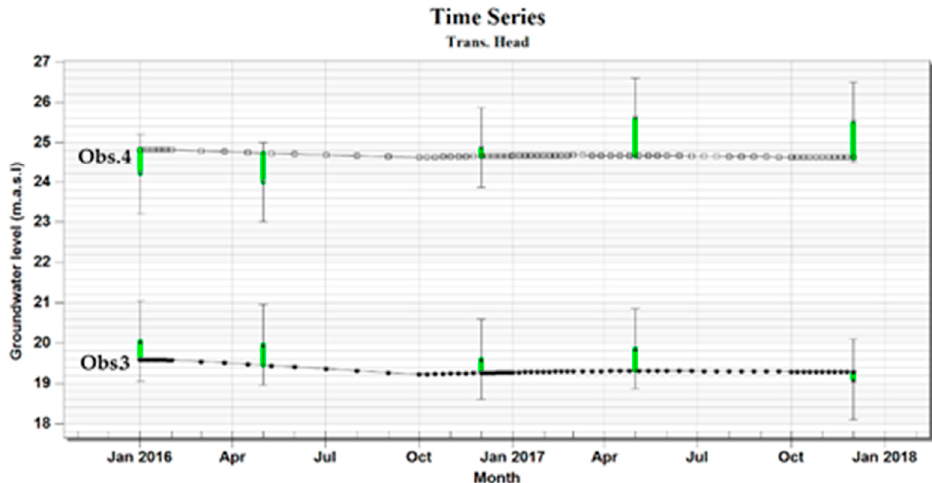
Figure 8. Validation in four observation wells during the transient period 2016–2017.